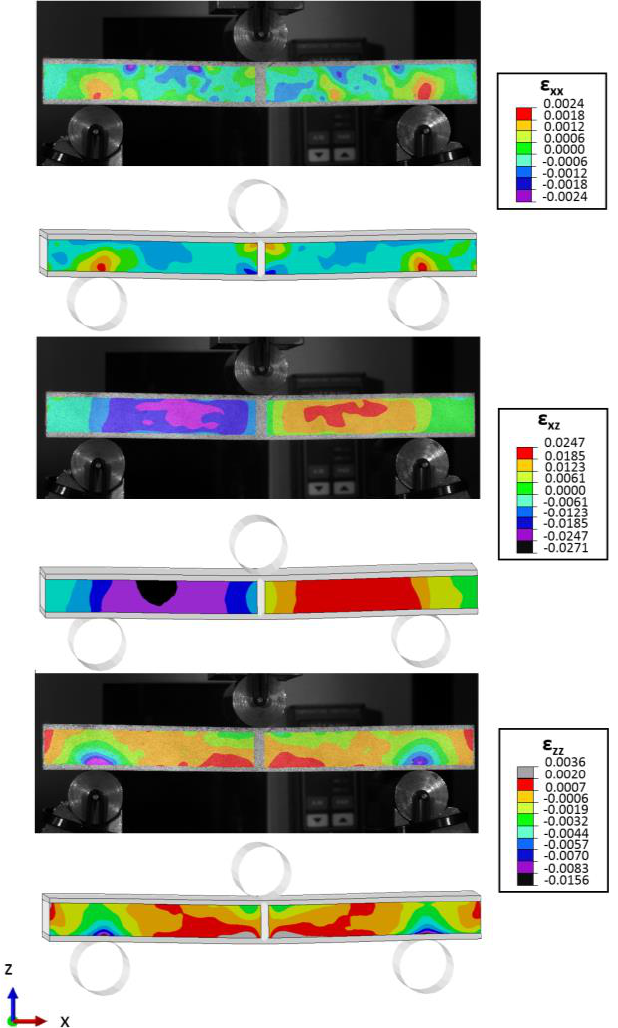
Figure 13. Comparison between DIC and FEA strain contours (applied displacement of 1.5 mm) for ‘Configuration 2’. For each component of strain, the experimental (DIC) result is shown first. As with ‘Configuration 1’, the FEA model generally overpredicts peak strain values for ‘Configuration 3’, shown in Figure 14. The overpredicted values are especially apparent in the areas where localised core compression occurs (i.e., beneath the central loading roller). The maximum shear strain ( ε xz ) value was over-predicted by the numerical model by a factor of about